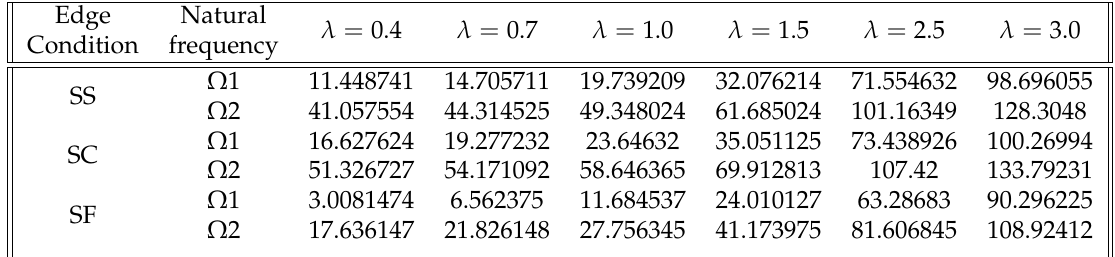
Table 6. Variation of aspect ratio on natural